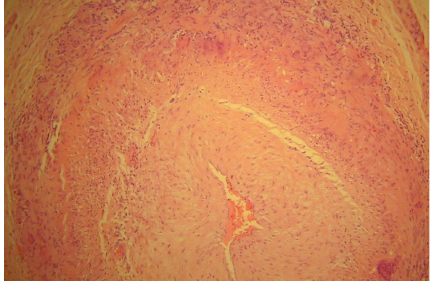
Figure 3: Temporal artery biopsy showing